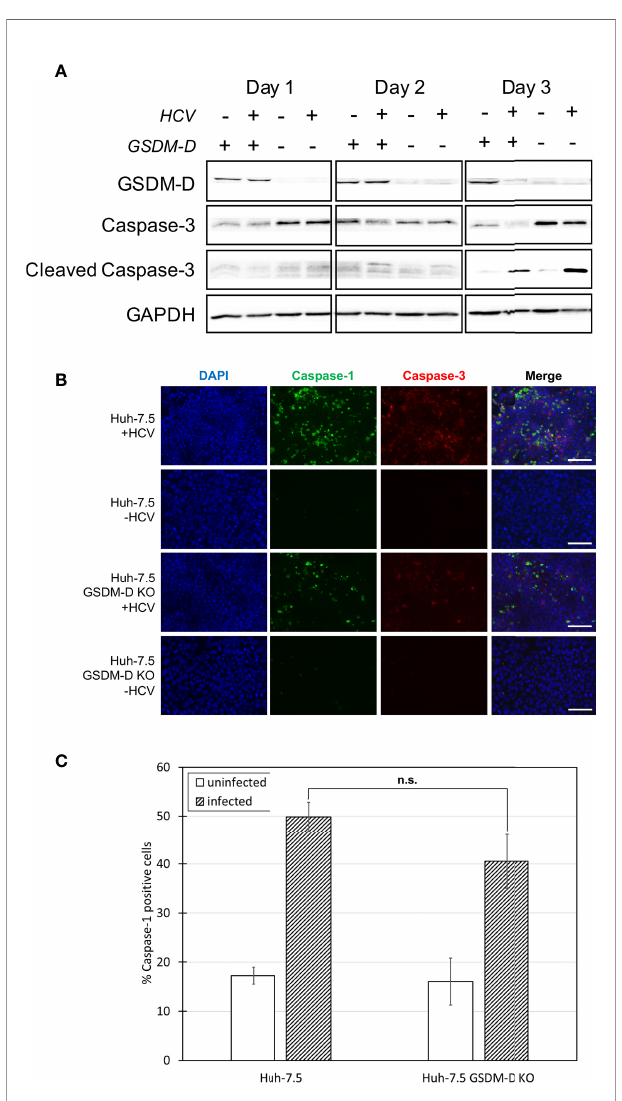
FIGURE 3 | Analysis of caspase-1 and -3 levels in the absence of GSDM-D. Huh-7.5 cells or Huh-7.5 GSDM-D KO cells were infected with HCV at MOI = 1 or left uninfected. (A) At 1, 2, and 3 days p.i., cells and culture fl uids were harvested for Western Blot analysis. Membranes were probed for